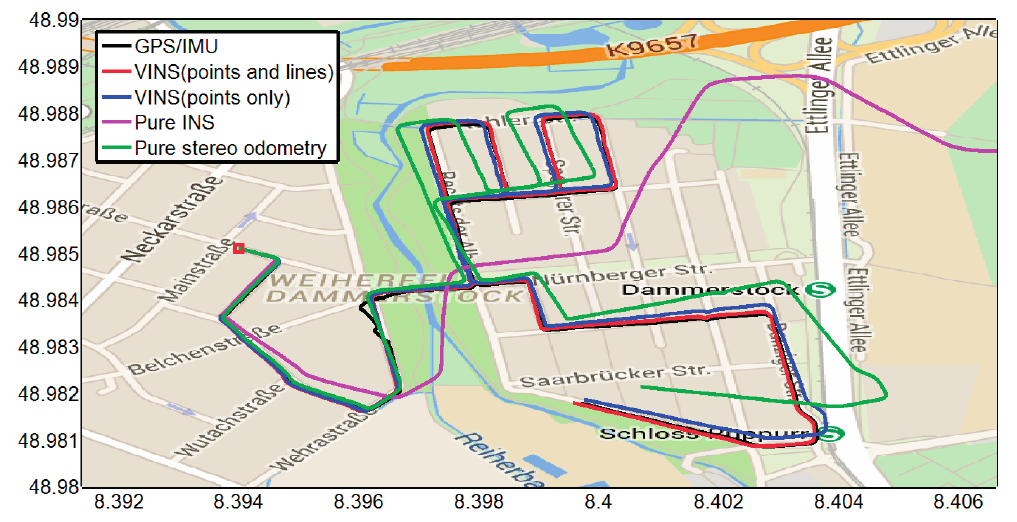
Figure 3. The motion trajectory plot on Google Maps. The initial position is denoted by a red